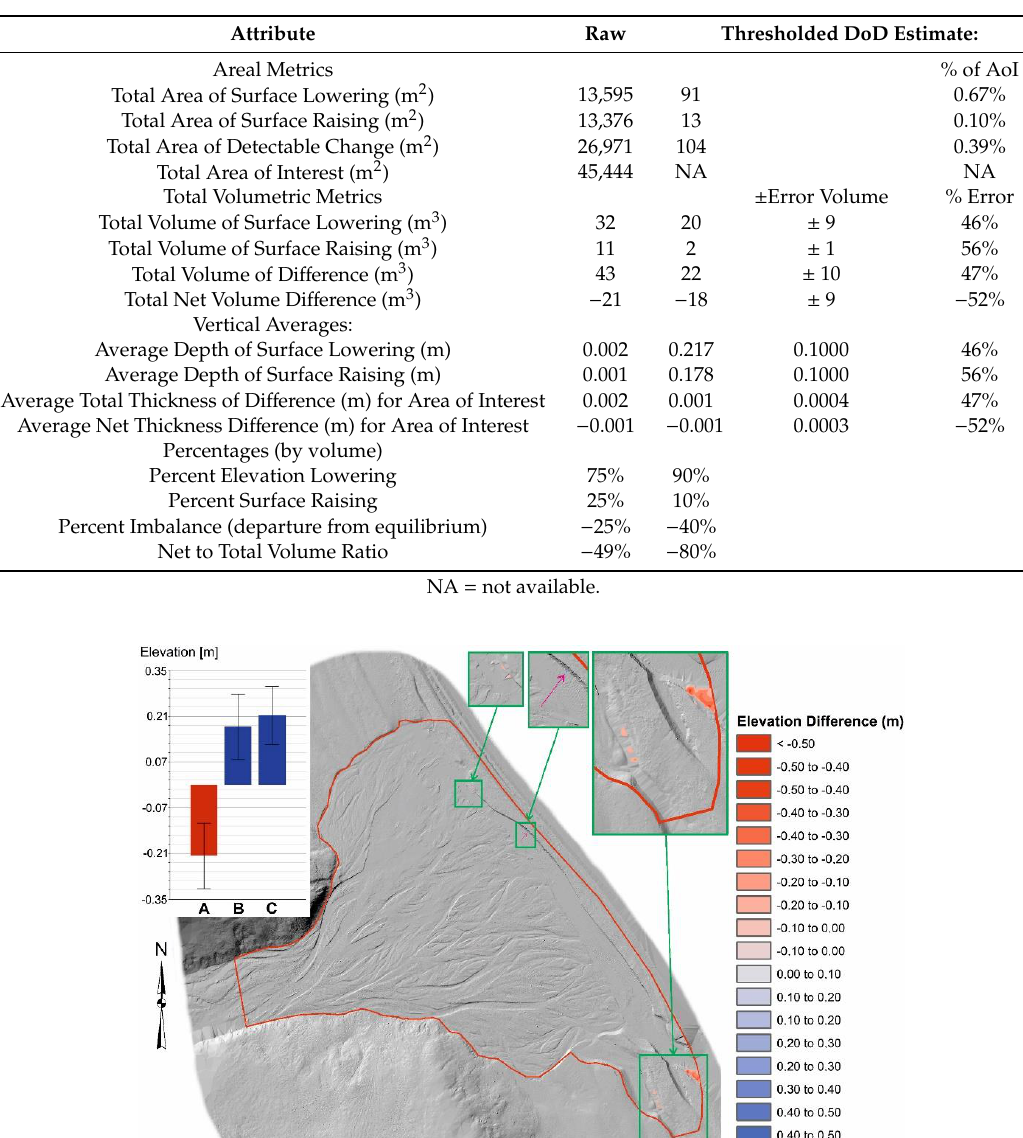
Table 4. Changes in physical parameters of the Area of Interest in July 2013 calculated volumetrically with reference to the total volume of the gravel-cobble material’s net change recorded by the DoD (both lowering and raising) from the manually cleaned-up (new) to the CSF-filtered (old) DTM. The uncertainty analysis was calculated by simply using the minimum level of detection (minLoD) approach while accounting for a uniform error of 0.1 m.